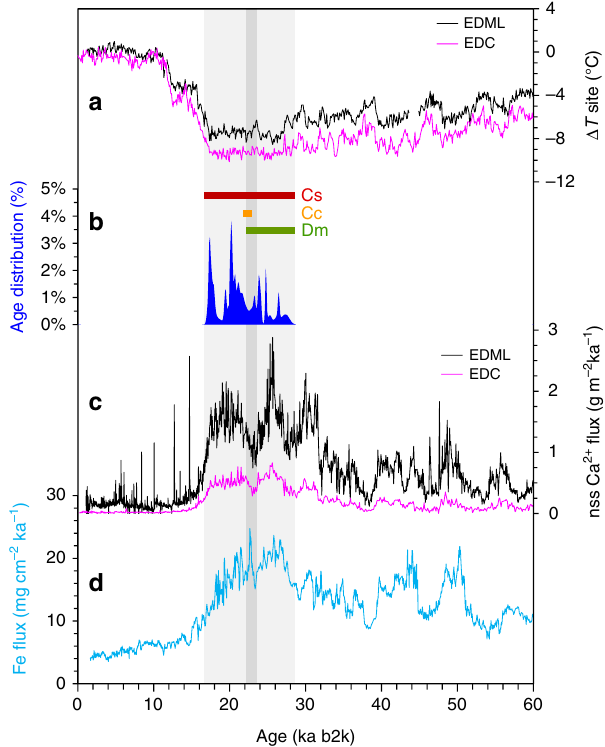
Figure 4 | Subglacial calcite age distribution in relation to LGM temperature and dust fluxes. ( a ) EPICA Dome C and EPICA DML temperature anomalies corrected for site elevation 41 ; ( b ) the age distribution of Boggs Valley calcites produced by using a normalized sum of each individual Gaussian distribution for all the 39 analyses where the [ 230 Th/ 232 Th] ratio is 4 30, including analytical errors (Supplementary Table 1). Analyses where the [ 230 Th/ 232 Th] ratio is o 30 are excluded from the plot. Horizontal bars above the age distribution highlight the changes of fabrics according to ages. Clear columnar Cs spans all ages. Isopachous Cc of clasts (Cc in Fig. 2, Supplementary Table 1) in the indurated sediment has a narrow range of ages, centred soon after the dust minima as identified by non sea-salt Ca fluxes ( c ). Dm is uncommon in layers younger than ca. 22 ka.; ( c ) non sea-salt Ca fluxes from EDML and EDC records 71 ; ( d ) the total Th normalized Fe flux in the Subantarctic Ocean reconstructed from ODP1090 2 . The dark grey vertical band identifies a discrepancy between Fe flux in ODP1090 and dust fluxes from EDC and EDML records, and coincide with low frequency of subglacial calcite formation. The ages of subglacial calcites correspond to the timing of the LGM (highlighted by the light grey vertical band) in both EDC and EDML, confirming that the calcite precipitates record an accurate archive of maximum ice